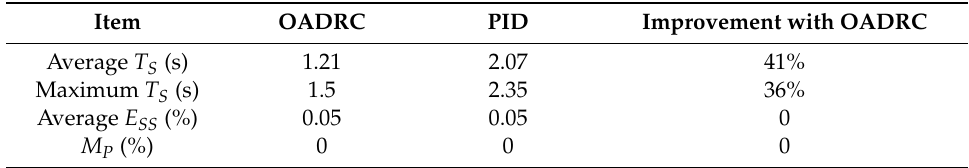
Table 7. Comparison between OADRC and proportional-integral-di ff erential (PID) controller with step changes of intake oxygen concentration.